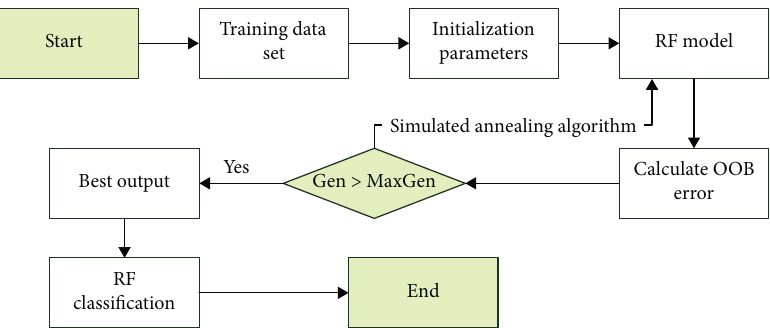
Figure 2: Irfc process of improved